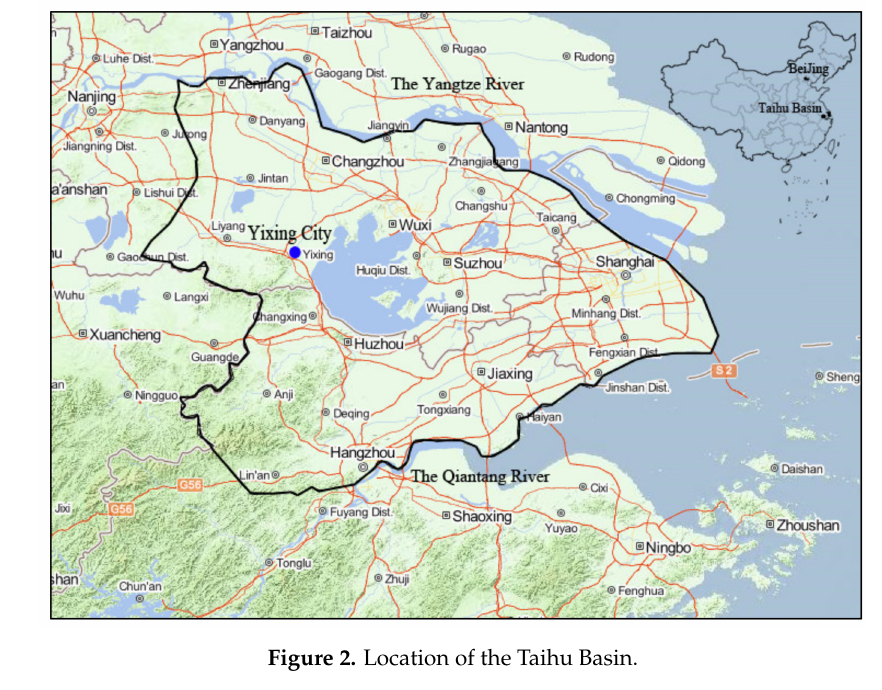
Figure 2. Location of the Taihu Basin.